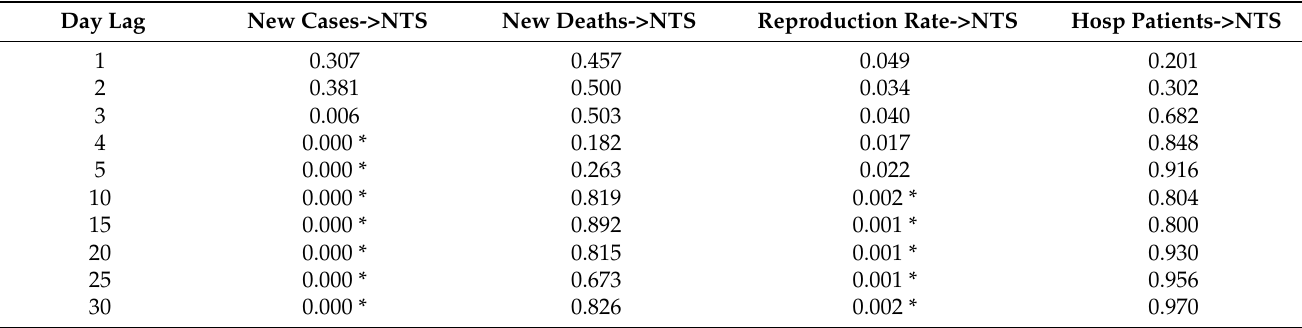
Table A12. Intensity variables, Granger-cause New_tests_smoothed (NTS), and p -values in day lags in Portugal.